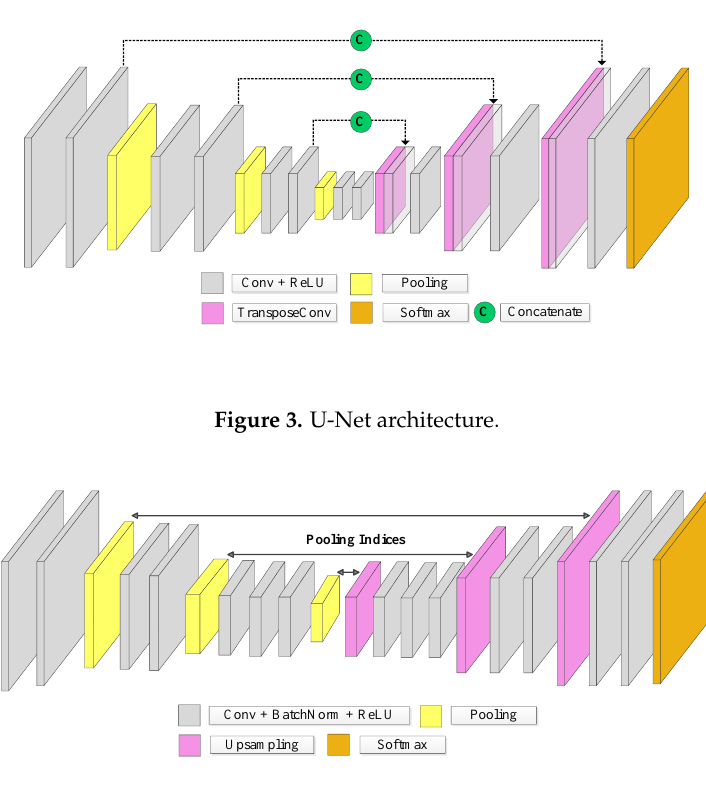
Figure 4. SegNet